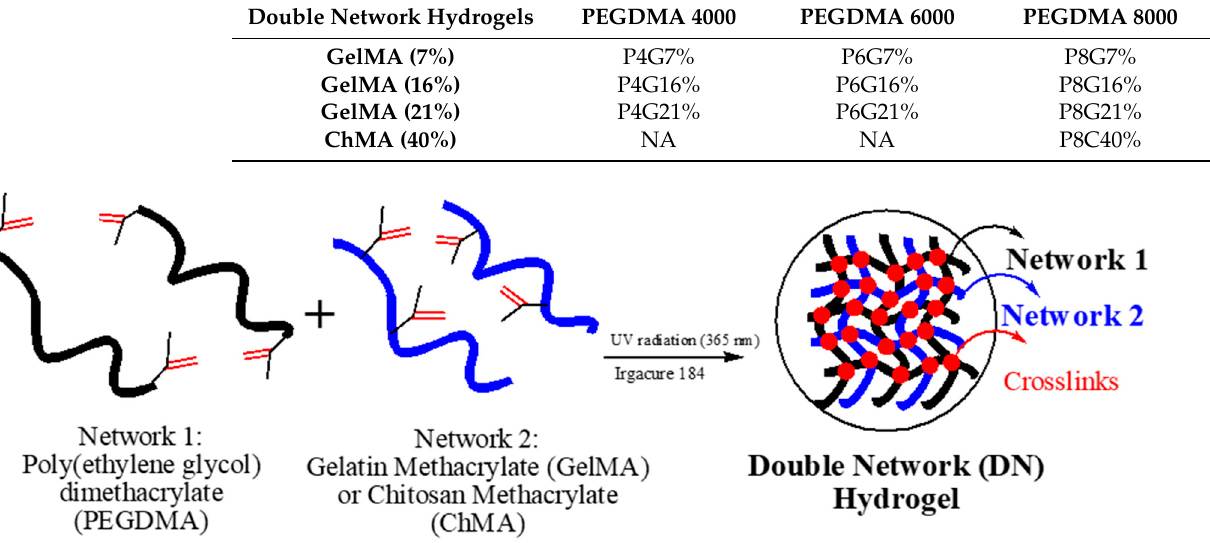
Figure 1. Photopolymerization reaction to obtain DN hydrogels .